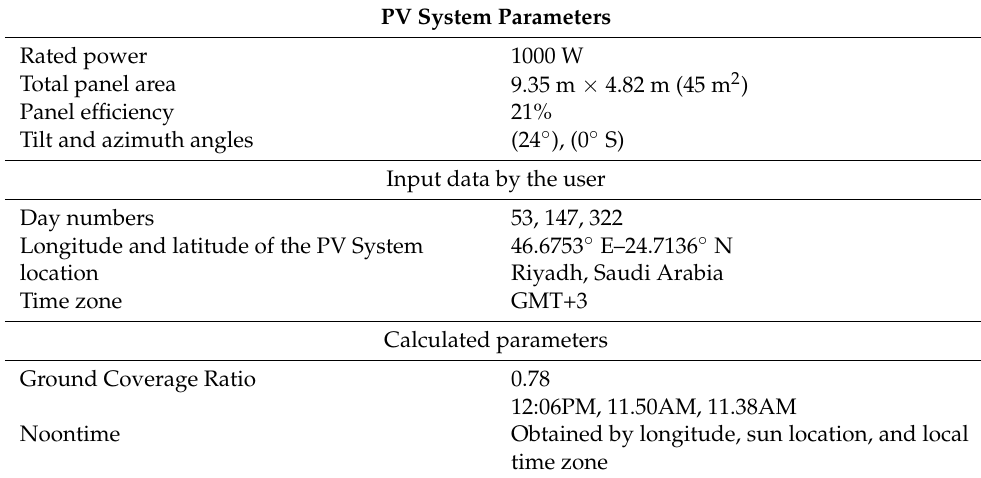
Table 3. Specifications of the studied PV system.